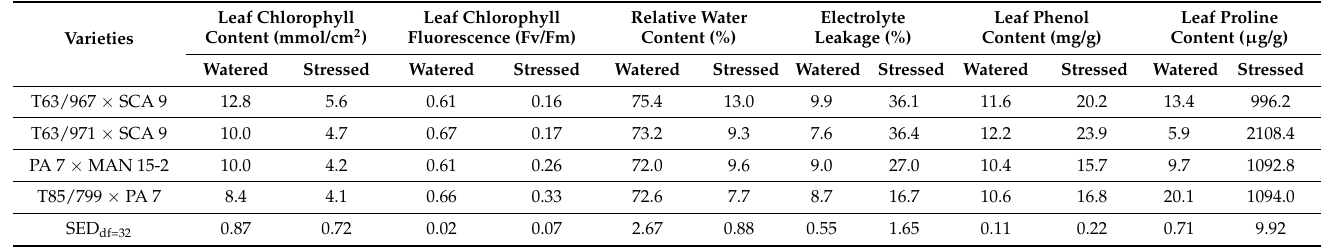
Table 6. Effects of watering regime and potassium levels on some physiological functions of four cocoa varieties in experiment 1 evaluated in a gauzehouse facility.